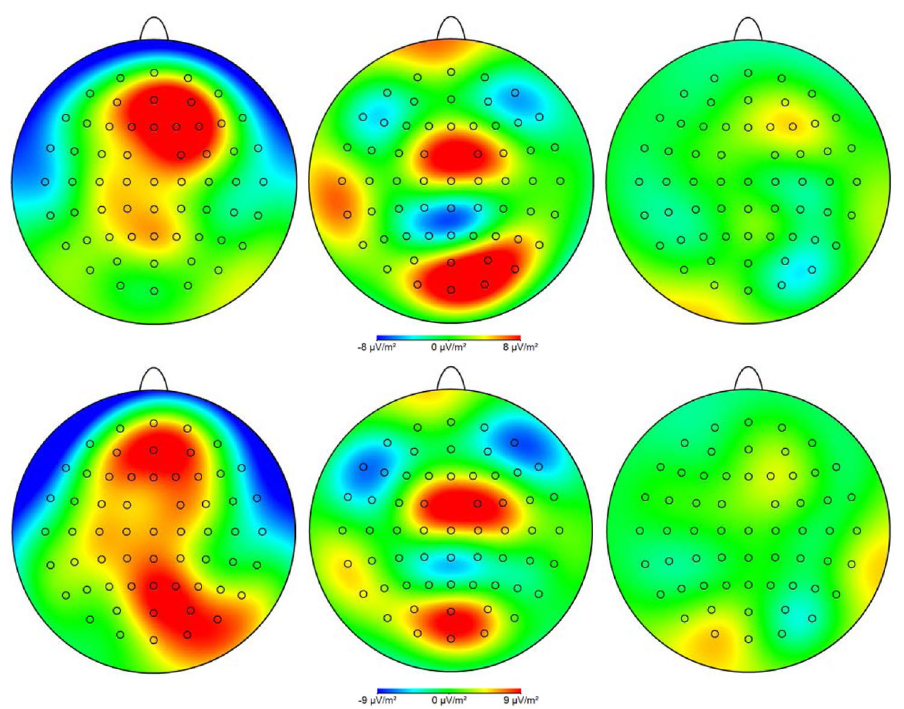
Figure 6. Neural processing of anxiety sweat (deviant stimuli) at the time of maximum P3-1 (upper row) and P3-2 amplitude (lower row) of non-pregnant women (left column), first-trimester pregnant women (middle column) and third-trimester pregnant women (right column), plotted as current source density (CSD) maps. Blue colours represent a weaker magnitude (neuronal sinks) and red colours represent a stronger magnitude of CSD (neuronal